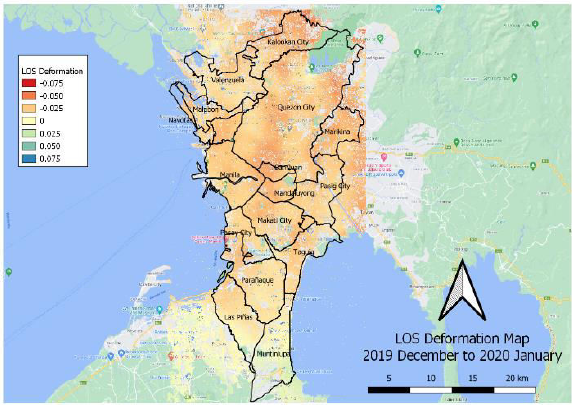
Figure 13. LOS Deformation (December 2019 – January 2020)